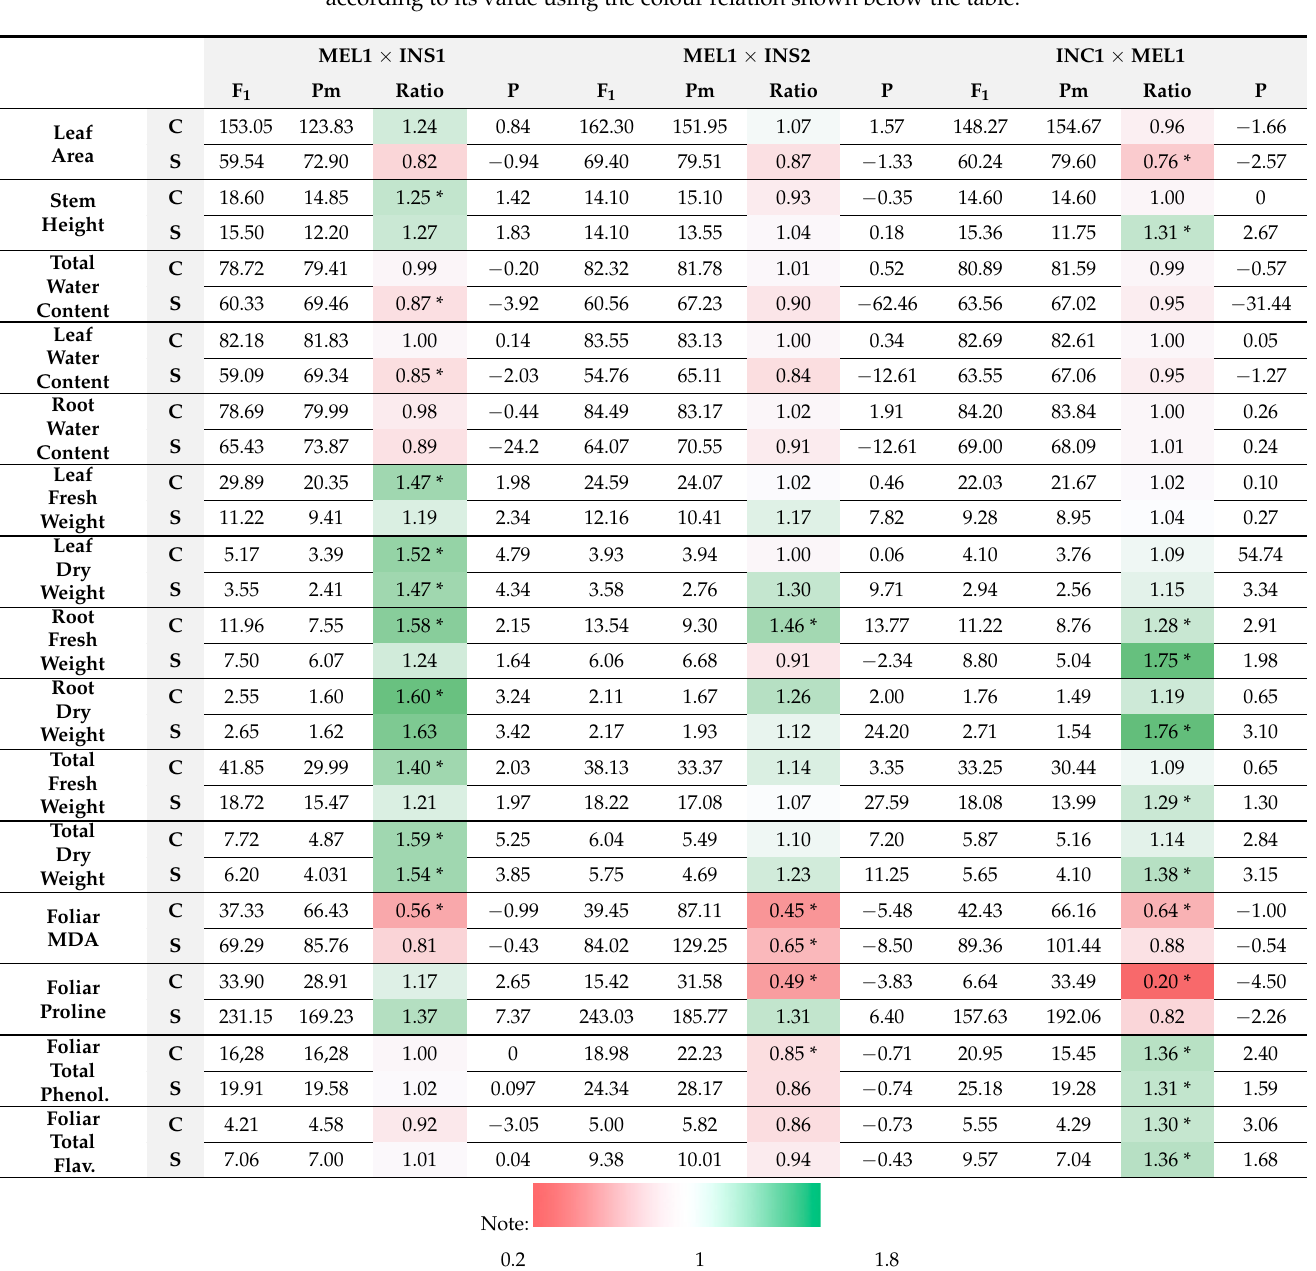
Table 3. Analysis of the hybrids using their mean parents. For each analysed parameter, the mean of the five biological replicates of hybrids (F 1 ), the mean parent (Pm), the F 1 /Pm ratio and Potence Ratio (P) are shown. One variable analysis of the heterosis by hypotheses test t , the asterisk indicates significant differences between the mean value of the F 1 and the mean parental. This ratio is coloured according to its value using the colour relation shown below the